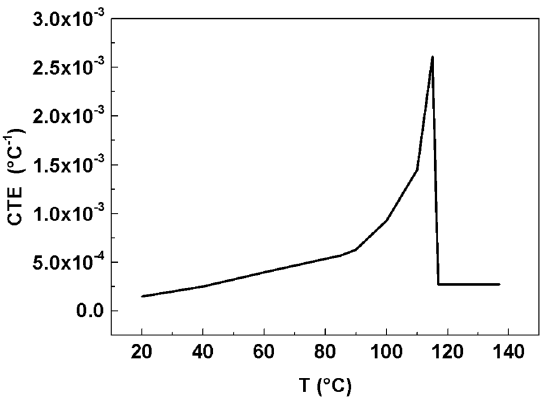
Figure 7. The coefficient of linear thermal expansion, CTE, vs. temperature, T, of an LDPE sub- strate.